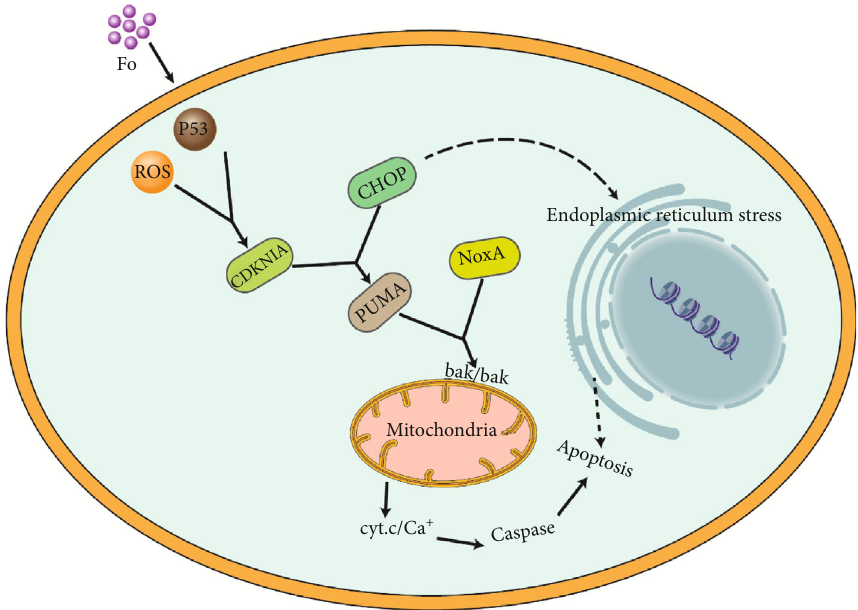
Figure 7: Schematic representation of the proposed model for the mechanism of FO-induced